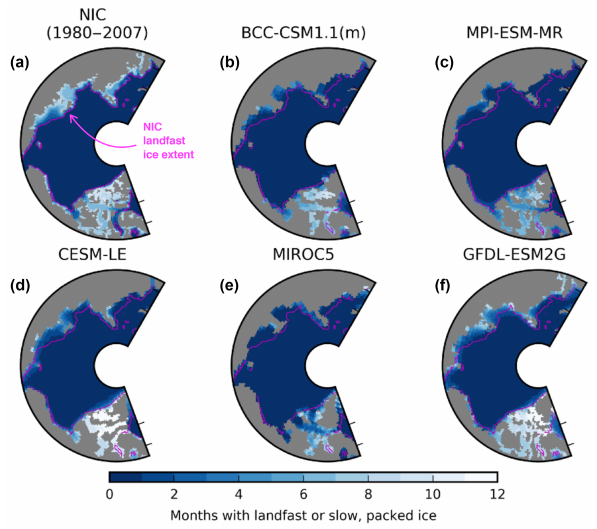
Figure 4. Same as Fig. 2 but for the trends in landfast ice duration over the indicated period. Significant trends ( p > 0 . 05) are indi- cated with stippling. Stippling was removed from some grid points to account for the false discovery rate (Wilks, 2006).